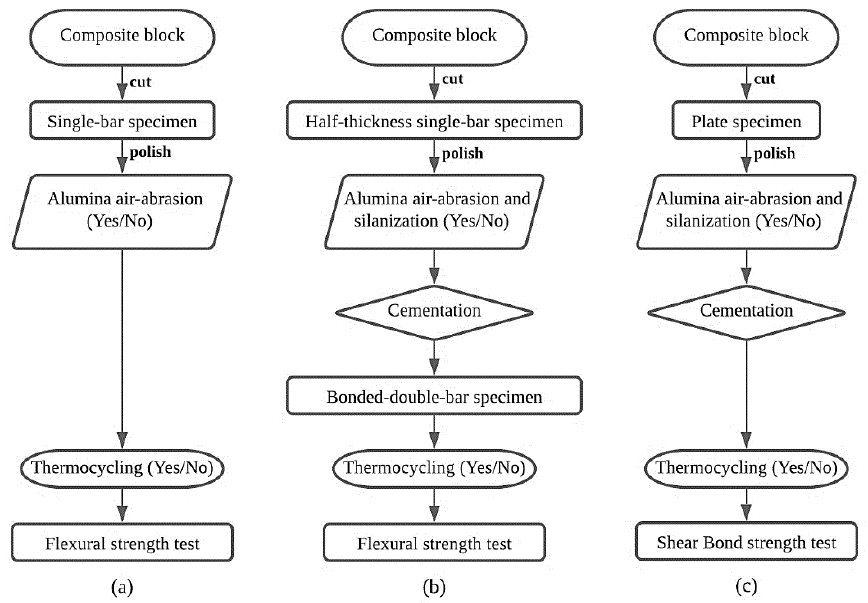
Figure 2. Protocol diagrams of the sample preparation and testing procedures for: ( a ) flexural strength testing for single-bar specimen; ( b ) flexural strength testing for bonded-double-bar specimen; ( c ) shear bond strength testing.